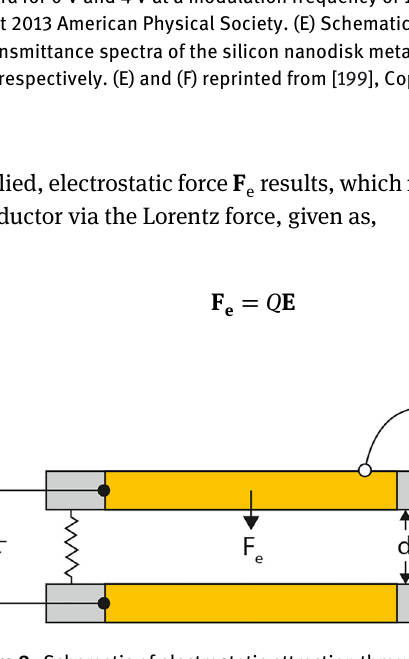
Figure 8: Schematic of electrostatic attraction through application of a voltage (V) across two conductors (gold), shown in cross-section. The top conductor (gold) is mounted to a nonconductive platform (gray), both of which are movable, where the springs provide a restoring force. The conductors have area (A) with an equilibrium separation distance